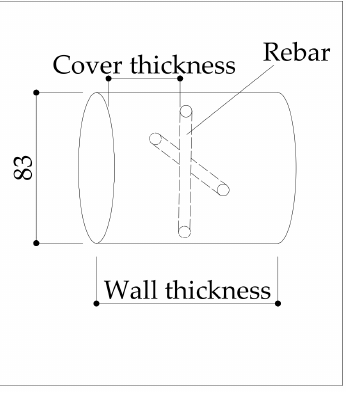
Figure 3. Detail of the concrete